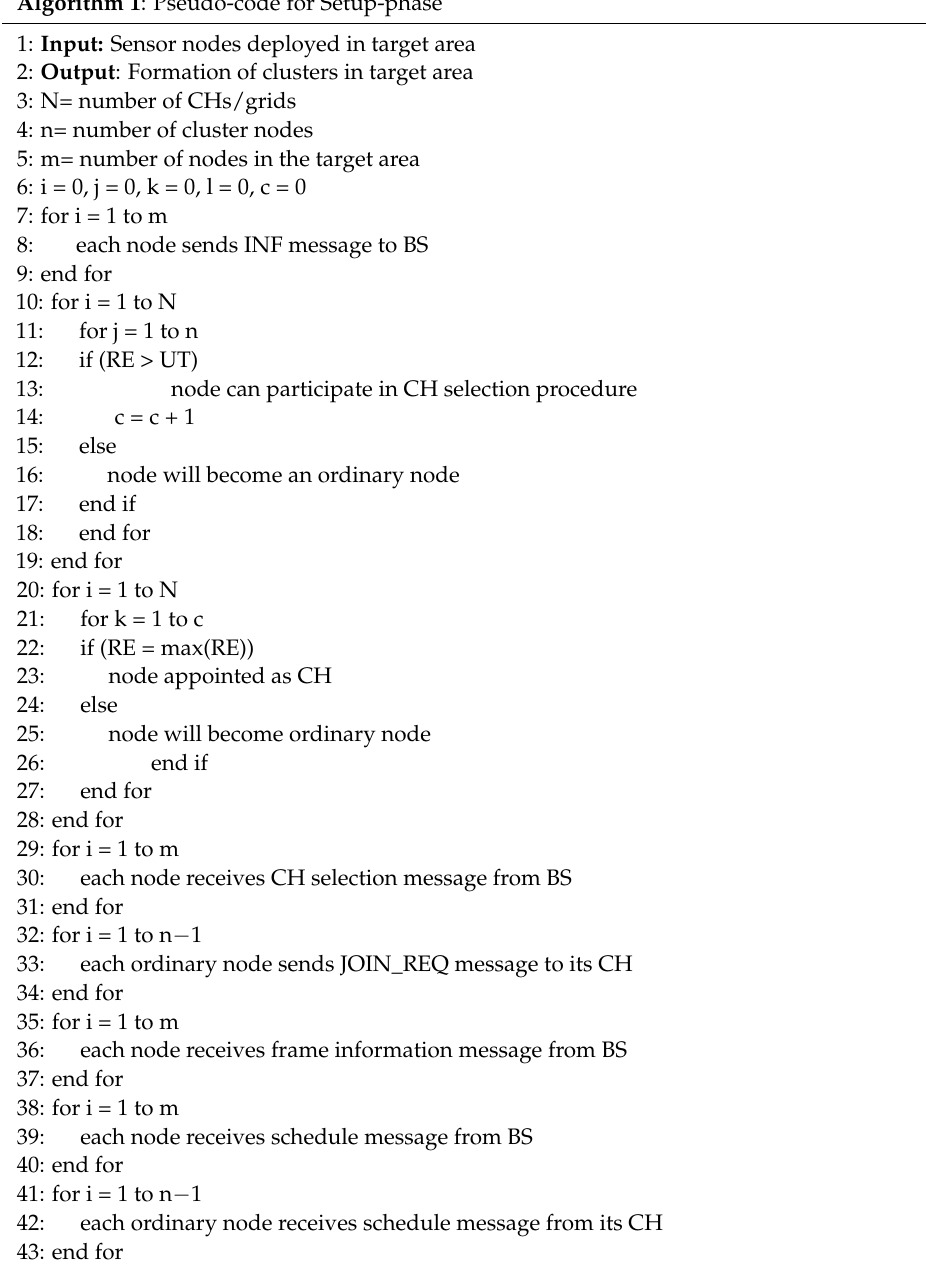
Algorithm 1 : Pseudo-code for